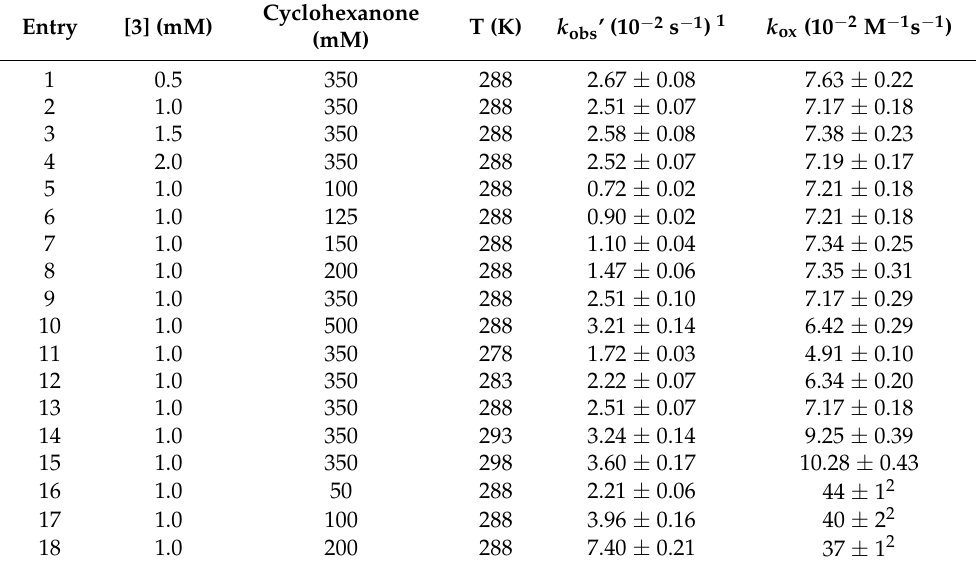
The change of 3 PhIO concentration derived from the reaction of 3 PhIO and cyclohexanone: [ 3 ] = 10 − 3